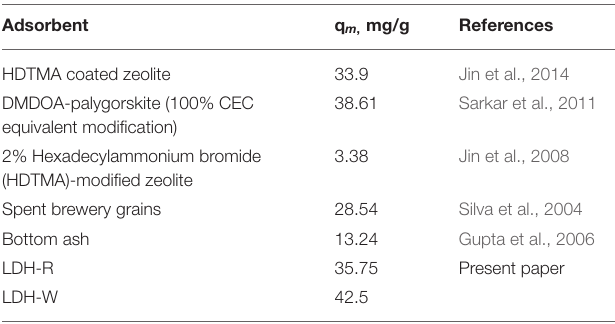
TABLE 1 | The comparison between the adsorption capacities of similar adsorbents developed in the treatment processes of aqueous solutions containing Orange